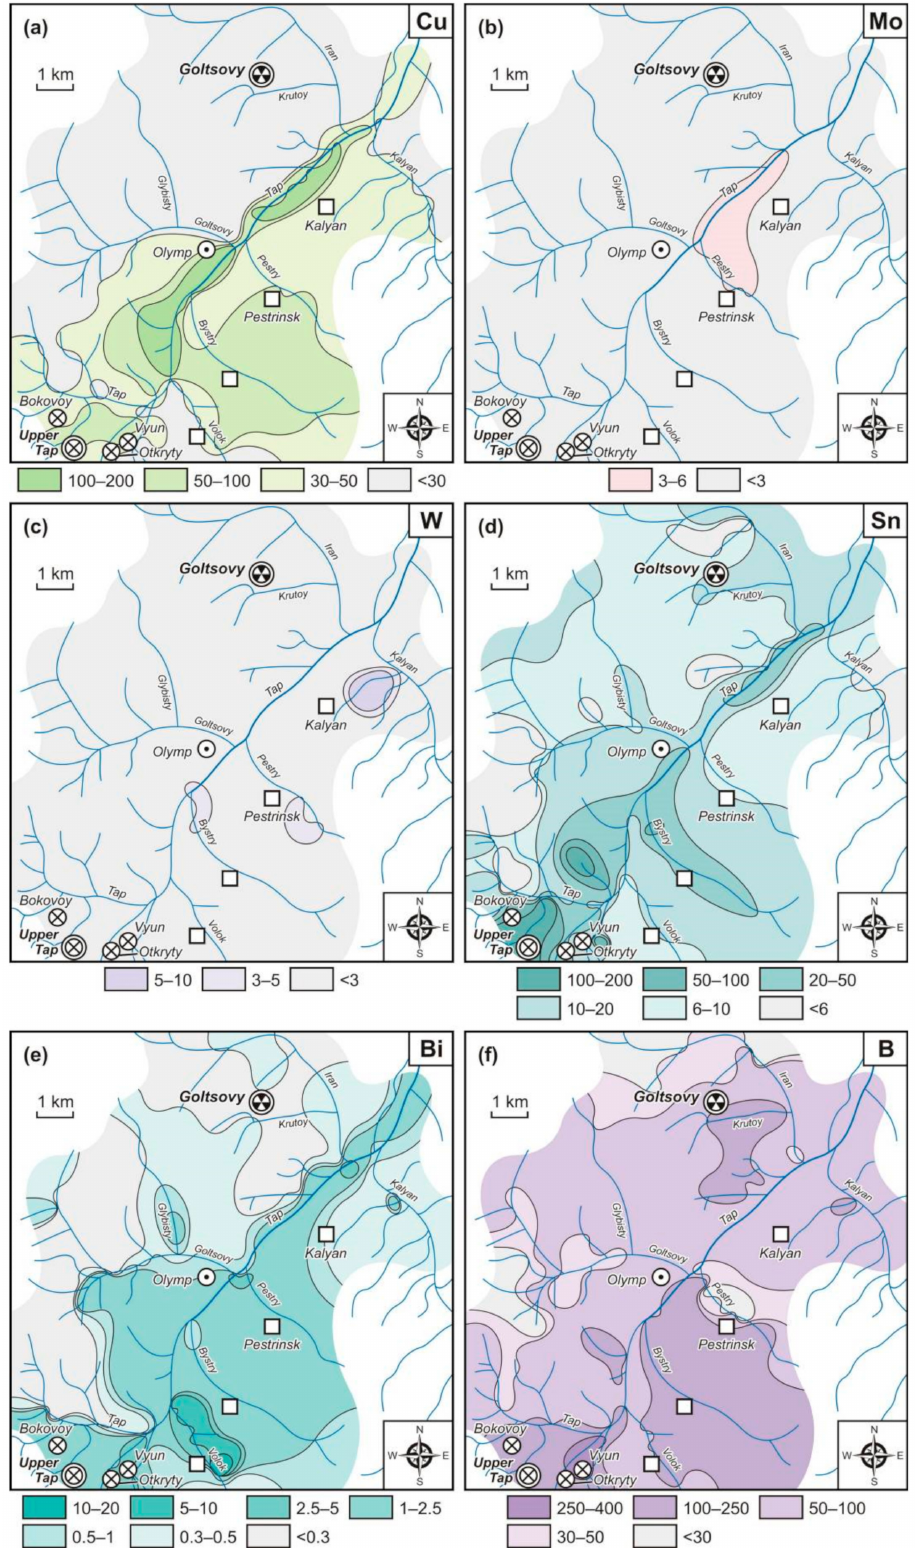
Figure 8. The Pestrinsk SBS (fragment). Exogenous Cu ( a ), Mo ( b ), W ( c ), Sn ( d ), Bi ( e ), and B ( f ) AGCFs identified through SSs (survey at a 1:50,000